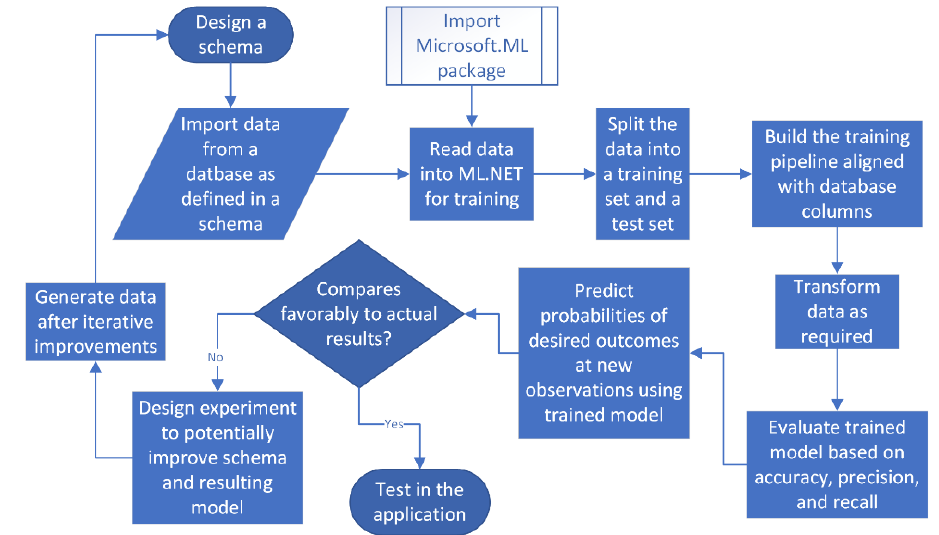
Figure 2. Flowchart of software developed in ML.NET.